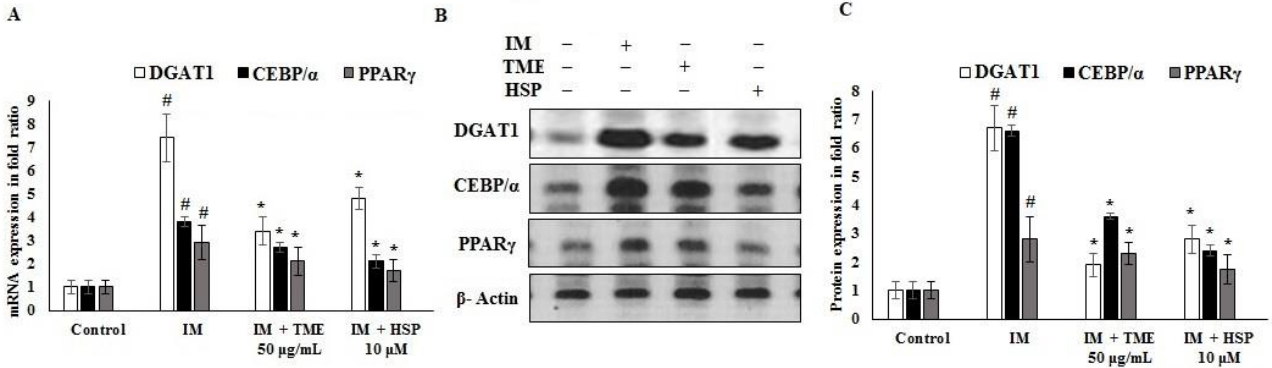
Figure 10. Effects of TME and HSP on mRNA and protein expression of DGAT1, CEBP/ α , and PPAR γ markers in 3T3-L1 cells evaluated by real-time PCR. 3T3-L1 cells were supplemented